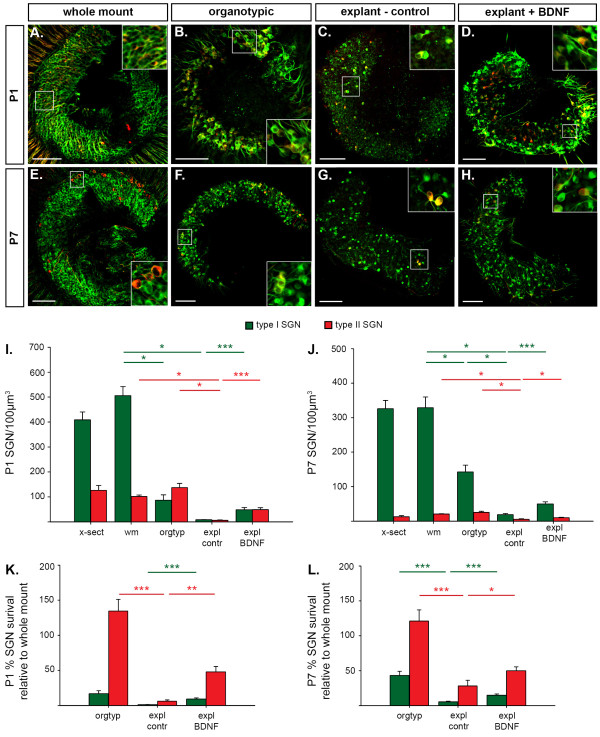
The organ of Corti (oC) maintains type II spiral ganglion neurons (SGNs), but not type I SGNs in organotypic culture and brain-derived neurotrophic factor (BDNF) rescues a greater proportion of type II SGNs following explant culture without the oC. (A- H) Single plane confocal images of β-tubulin (green) and peripherin (red) immunofluorescence in the mid-apex-mid-turn region of cochleae from P1 (A-D) and P7 (E-H) mice enabled analysis of type I SGN (immunolabel for β-tubulin only) and type II SGN (immunolabel for β-tubulin and peripherin) density. SGN density in the mid-apex-mid-turn region in vivo was determined in whole mount tissue (whole mount) (A,E). Survival of SGN sub-types was subsequently established following 48 hour culture of cochlear tissue: retaining both SGNs and oC (organotypic) (B,F); just the spiral ganglion, following removal of the oC (explant - control) (C,G) and this spiral ganglion explant cultured with 100 ng/ml BDNF (explant + BDNF) (D,H). Inset shows marked area in corresponding panel at higher magnification and shows detail of type I and type II SGNs. (I,J) Neuron densities for type I (green) and type II (red) SGNs from P1 (I) and P7 (J) mice are plotted for each condition shown in panels (A-H). x-sect, mid-apex-mid-turn ganglion in mid-modiolar cross-sections; wm, whole mount; orgtyp, organotypic; expl BDNF, explant + BDNF; expl contr, explant - control. Mean density and standard error of the mean; one-way ANOVA with post hoc Holm Sidak tests compare SGN survival in the wm, orgtyp and expl contr; unpaired t-tests compare expl contr and expl BDNF; *P < 0.05, ***P < 0.001. (K,L) Percentage survival of type I and type II SGNs in orgtyp, expl BDNF and expl contr relative to mean in vivo whole mount densities are plotted for P1 (K) and P7 (L) mice. Mean density and standard error of the mean; unpaired t-test, *P < 0.05, **P < 0.01, ***P < 0.001. Scale bars: 250 μm.